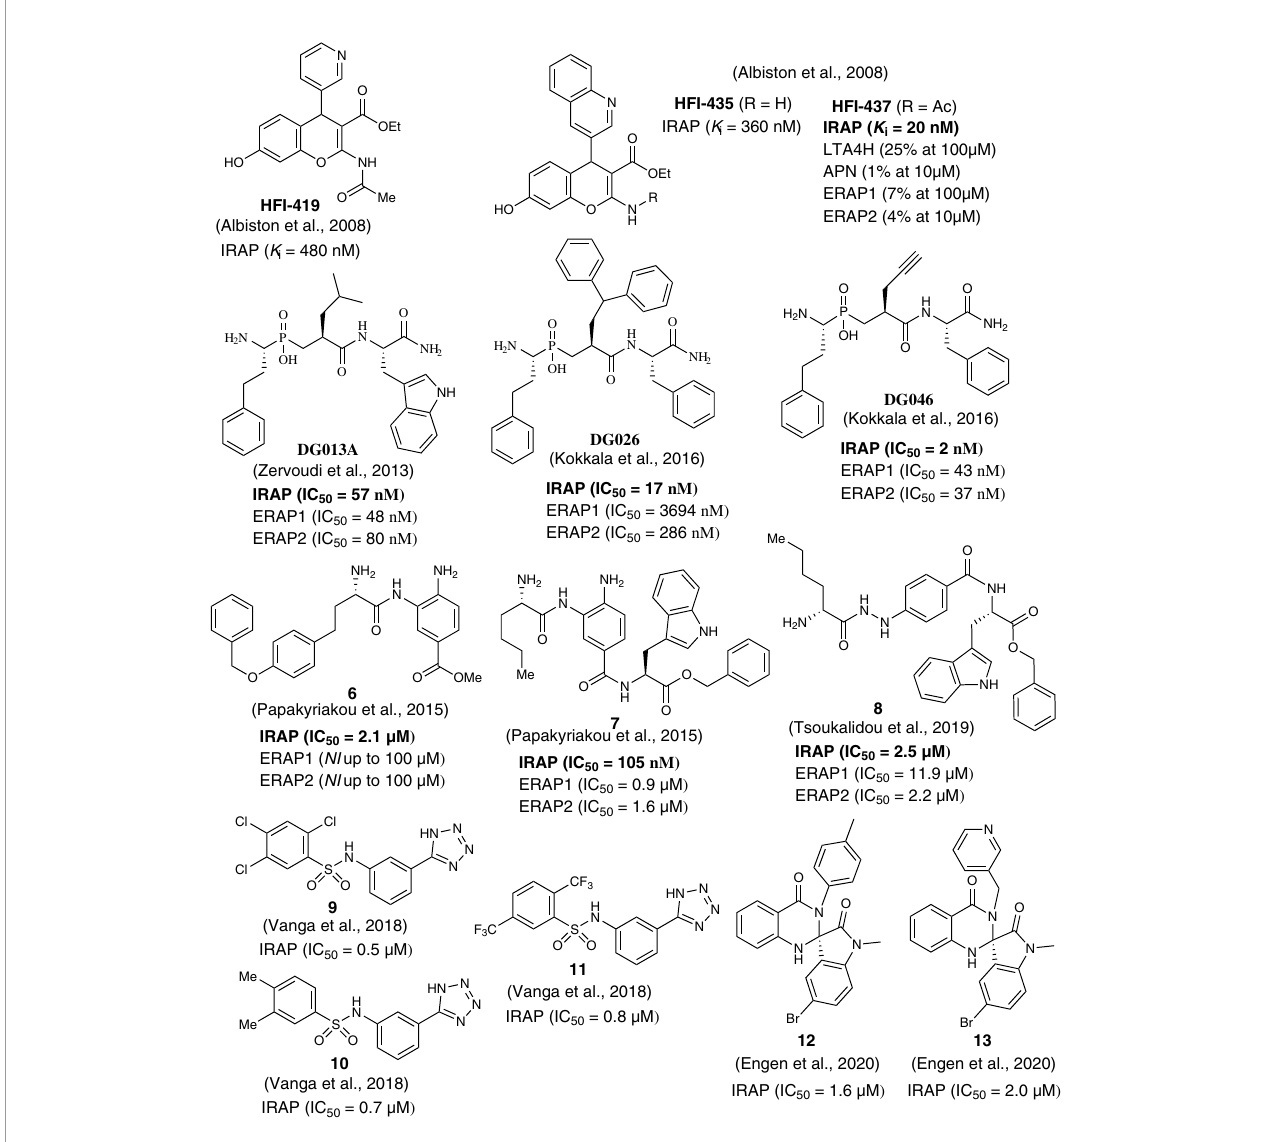
FIGURE 2 | Chemical structures of non-AngIV based inhibitors of IRAP 6-13 , HFI-410 , HFI-435 , DG013A , DG026 , and DG046 . K i or IC 50 values for IRAP are given in all cases. K i or IC 50 values for other aminopeptidases are also provided, if